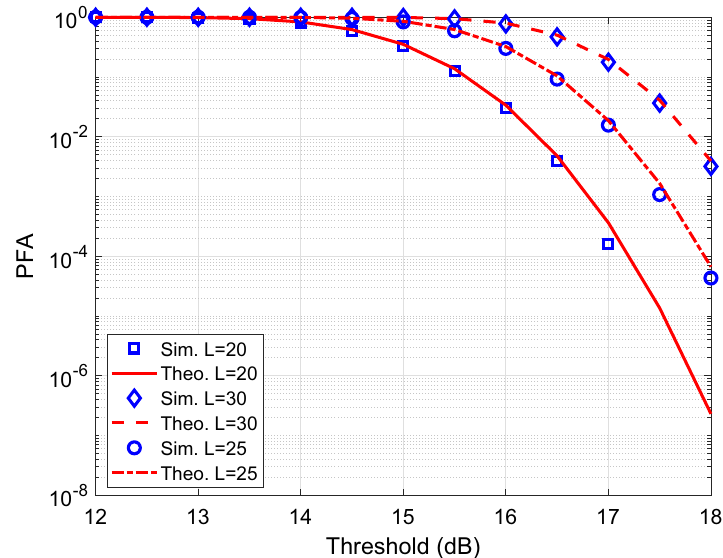
Fig. 4 PFA versus threshold value for different L